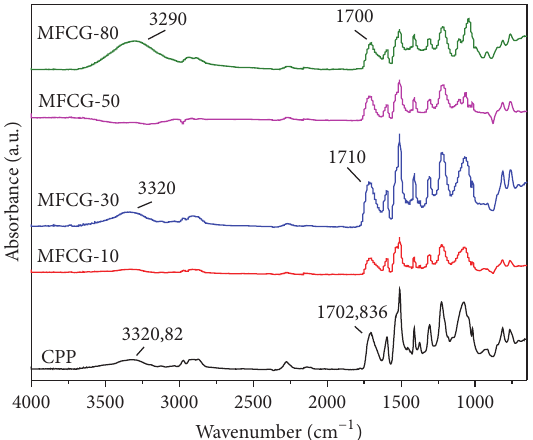
Figure 2: FTIR results of PUF samples with methanol-free crude